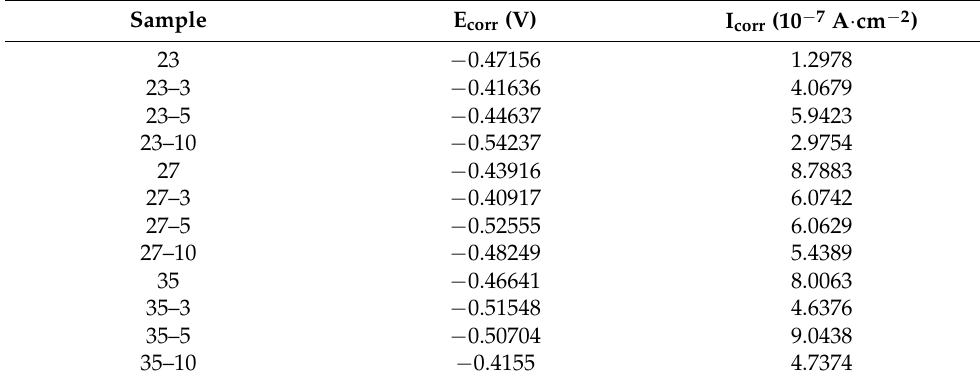
Figure 11. Potentiodynamic polarization curves of composites based on Ti23Mo ( a ), Ti27Mo ( b ), and Ti35Mo ( c ). Table 5. Corrosion potential (E corr ) and current density (I corr ) of all sintered specimens.